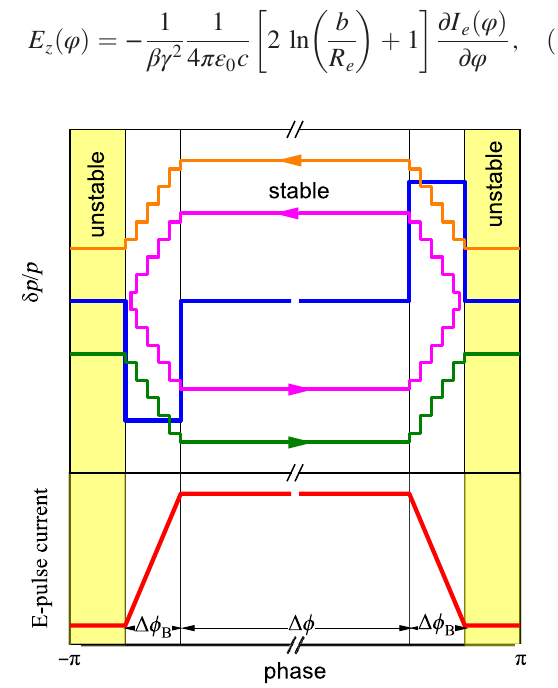
FIG. 4. Schematic view of the barrier bucket generated by a pulsed electron beam, and the particle motion in longitudinal phase space. (Blue: barrier potential in arb. units; magenta: separatrix orbit; orange and green: drift orbit outside the